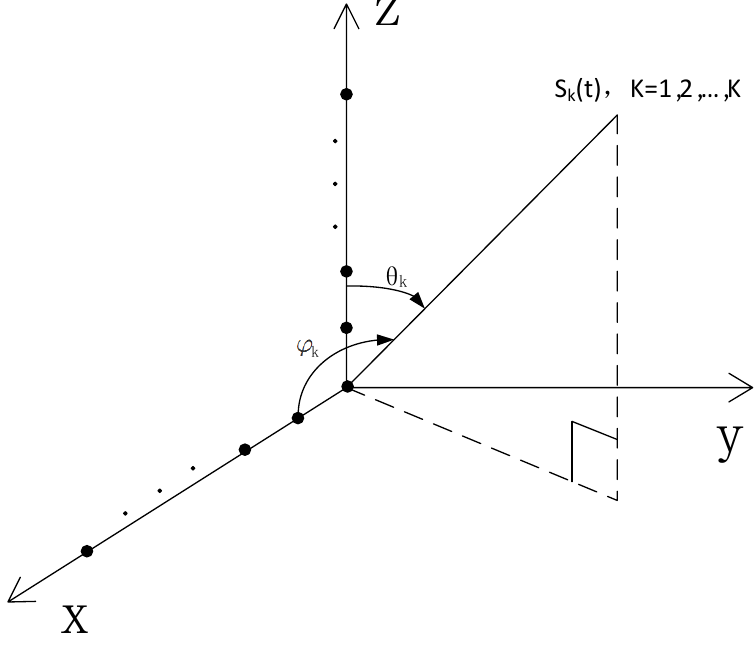
Figure 1. L-shaped array configuration for 2D DOA